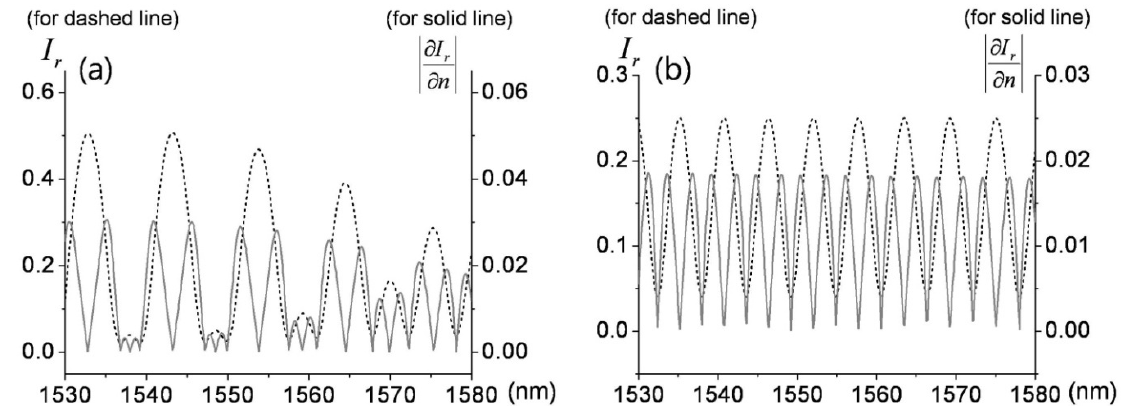
Figure 10. Simulated reflectance fringes and change in reflectance due to refractive index (which corresponds to EO sensing strength) for probe V (a) h h = 10 μ m , n = n = n . Part (b) is the same as (a) except h 2 1 3 e probe II)